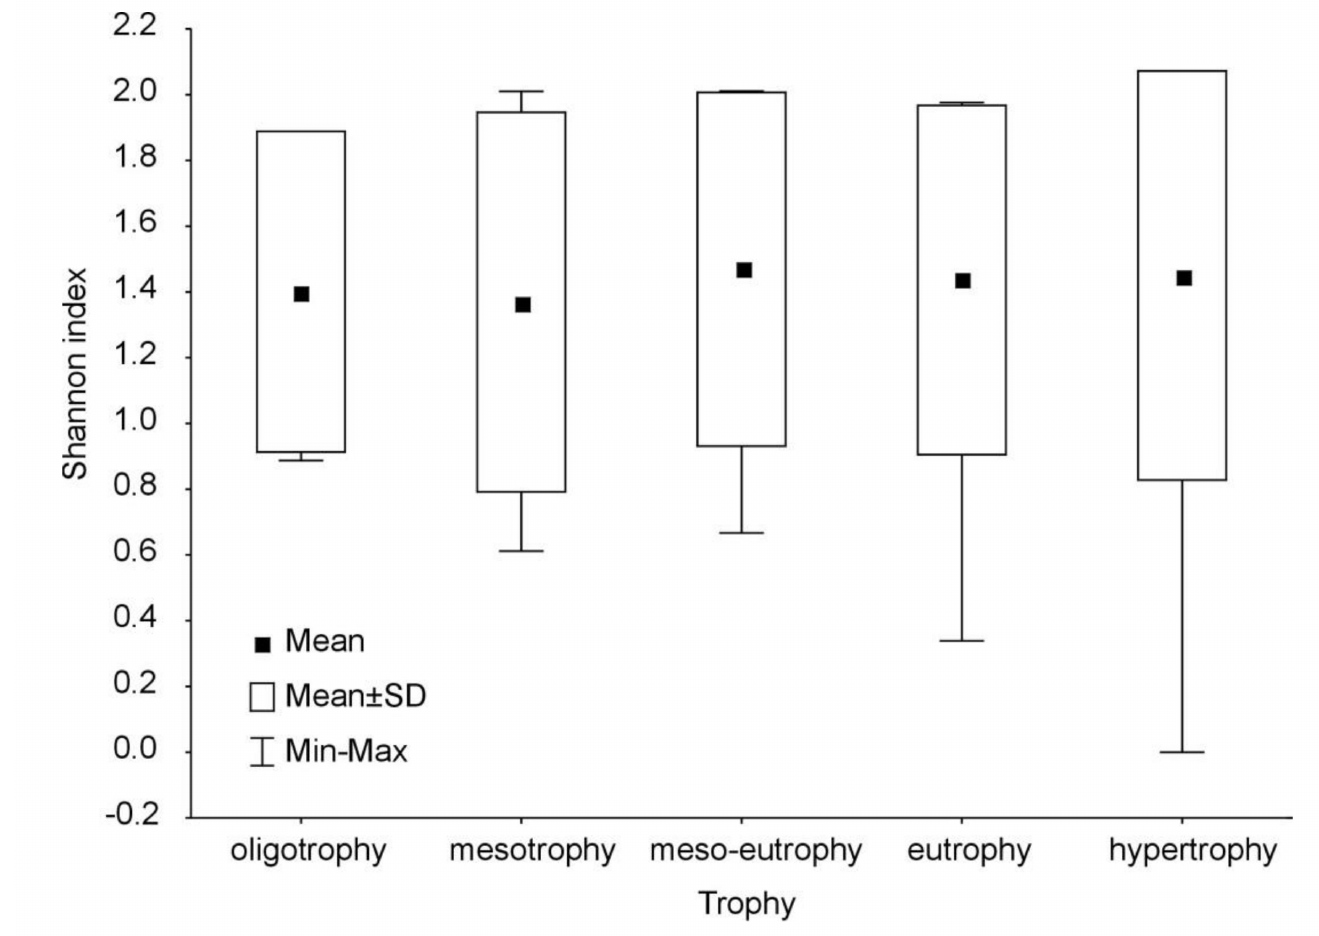
Figure 3. The Shannon index in 535 Polish lakes of different trophic status. Trophic conditions of the studied lakes were based on the trophic state index (TSI) of lakes, calculated from Secchi disc visibility according to Carlson [24]. SD = standard deviations.